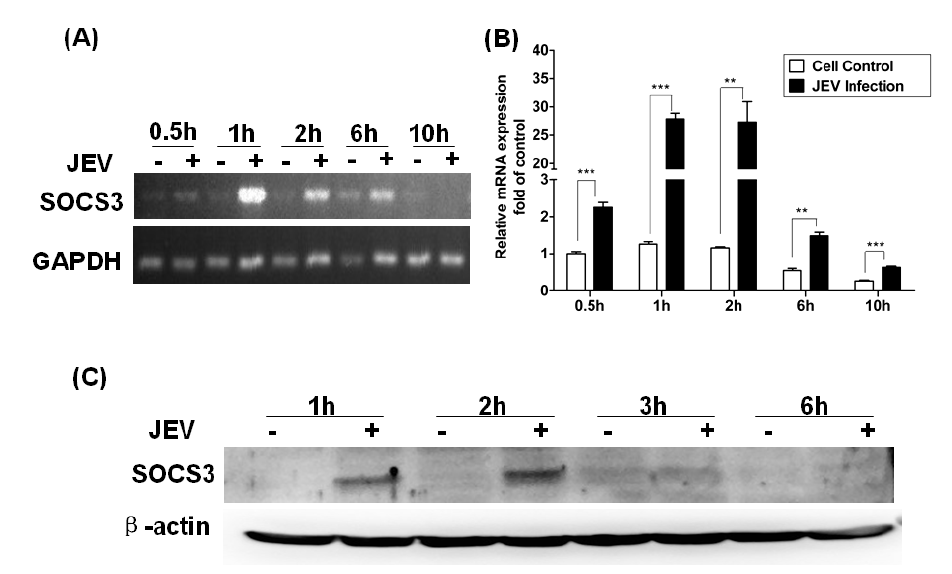
Figure 2. Changes in the expression of SOCS3 at the mRNA and protein levels in Raw264.7 cells infected with JEV. Raw264.7 cells were infected with JEV at 5 MOI, and samples were collected at different time points post infection (p.i.). Semiquantitative ( A ) and quantitative ( B ) RT-PCR was performed with RNA extracted from mock-infected or JEV-infected RAW264.7 cells. Results of quantitative RT-PCR were expressed as the fold change in relative SOCS3 mRNA expression over the control. Data are expressed as the mean ± SD from four independent experiments. ( C ) Expression of SOCS3 protein in mock-infected and JEV-infected RAW264.7 cells was analyzed by Western blotting. Differences were assessed by using unpaired Student’s t -tests. ** p < 0.01, *** p <